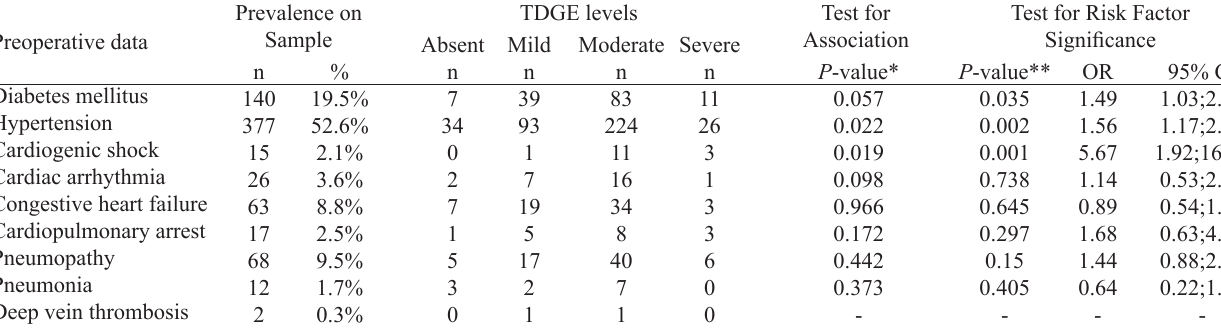
Table 3. Association of history and preoperative comorbidities with postoperative TDGE.